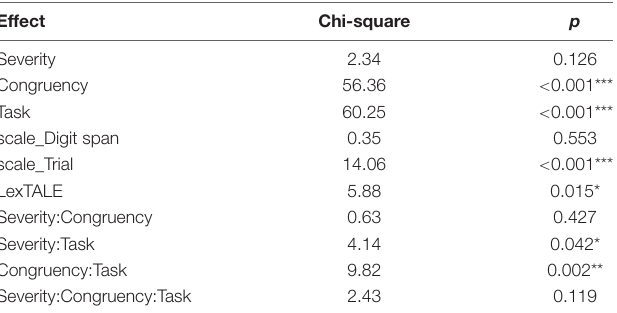
TABLE 4 | Linear mixed-effects model with severity, congruency, task as the fixed effects and the logarithm of reaction time as dependent variables in Experiment 1. Effect